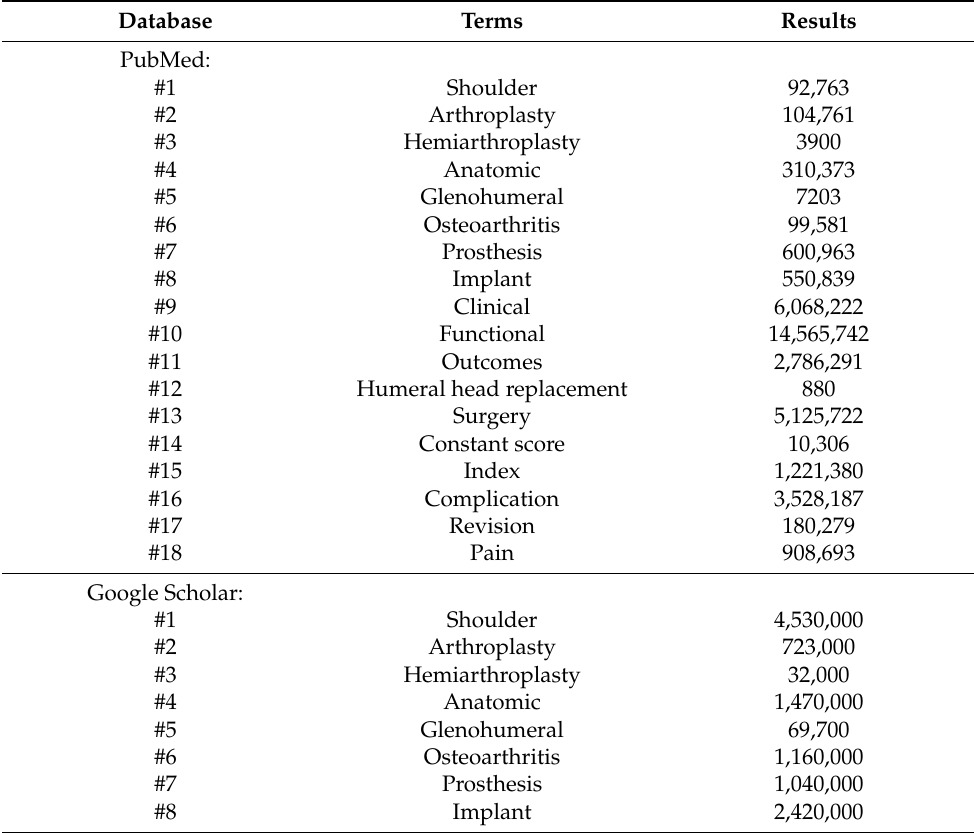
Table 1. Search strategy for the electronic